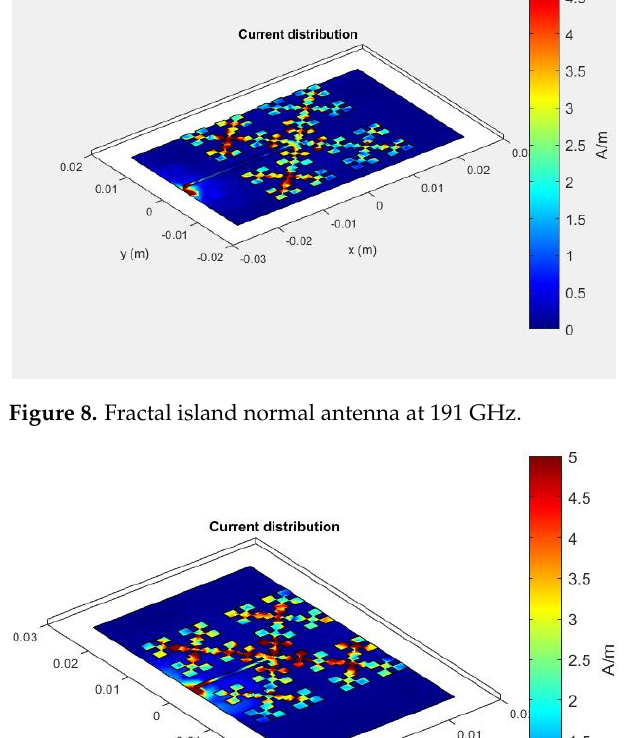
Figure 8. Fractal island normal antenna at 191 GHz.